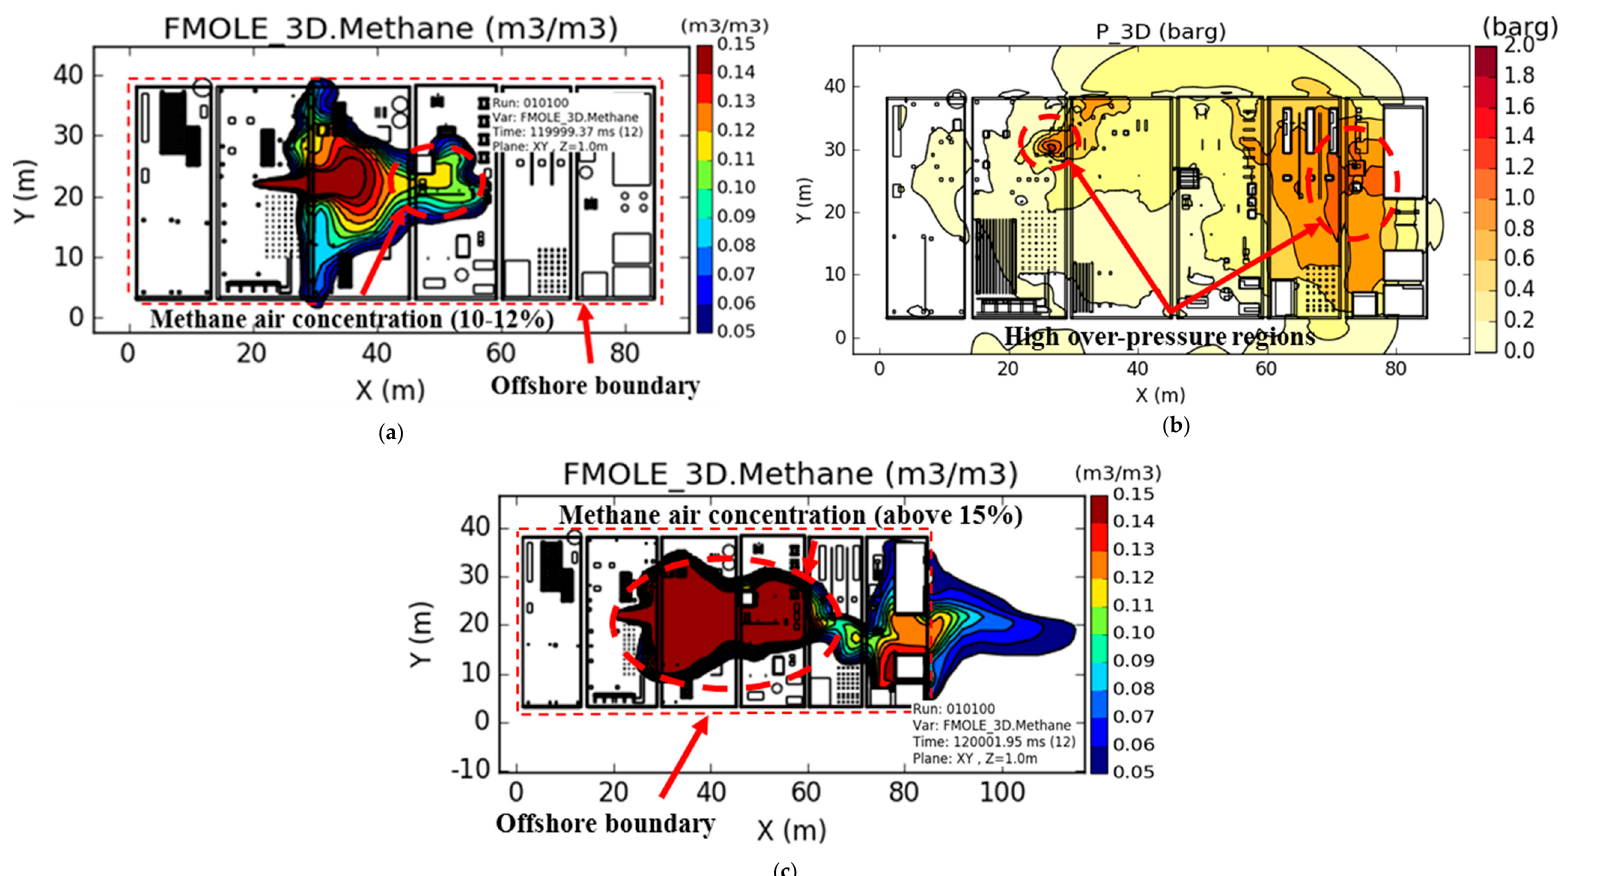
Figure 12. Methane–air concentration profile and overpressure by VCE for RX+ leak direction and wind speed of 3 m/s. ( a ) Concentration profile of methane–air mixture at 16 kg/s leak rate. ( b ) Overpressure contour at 16 kg/s leak rate. ( c ) Concentration profile of methane–air mixture at 61 kg/s leak rate.